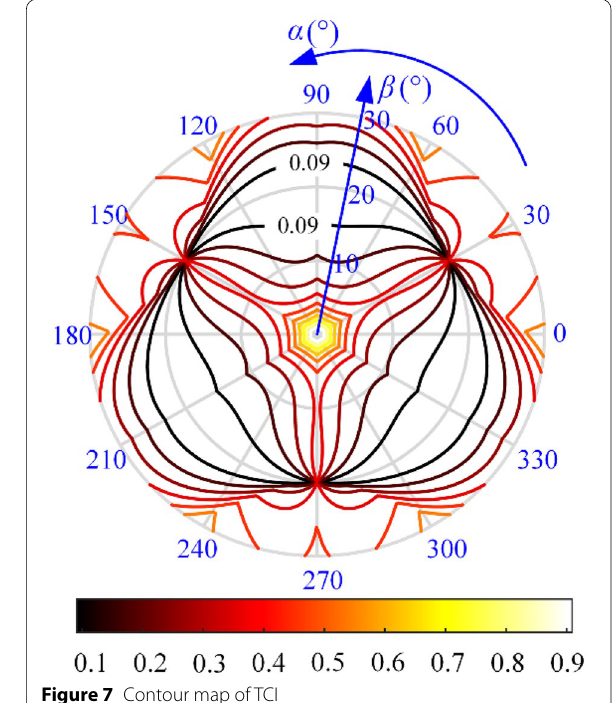
Figure 7 Contour map of